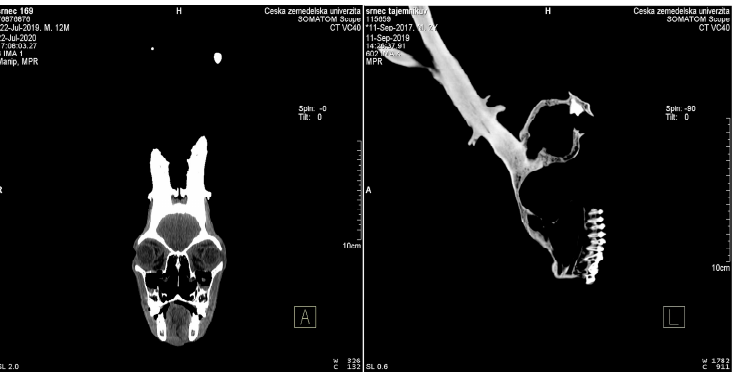
Figure 9. CT scanner—an internal image of a roe deer skull with visible tooth roots and antler struc- ture.